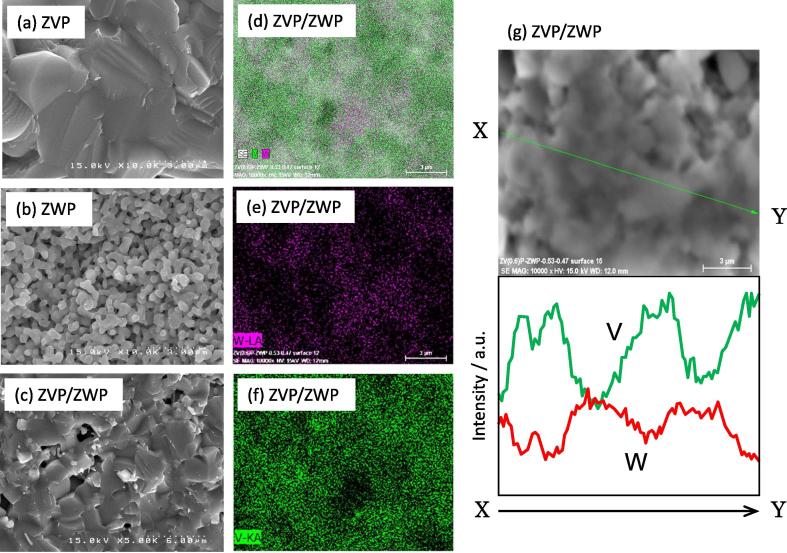
SEM images of fracture surfaces of sintered bodies of (a) ZrV0.6P1.4O7 (ZVP), (b) Zr2WP2O12 (ZWP), and (c) ZVP/ZWP composite fabricated at 1000 °C for 20 h in air and EDX composition maps (d) W and V, (e) W, (f) V, and (g) line analysis for ZVP/ZWP composite.